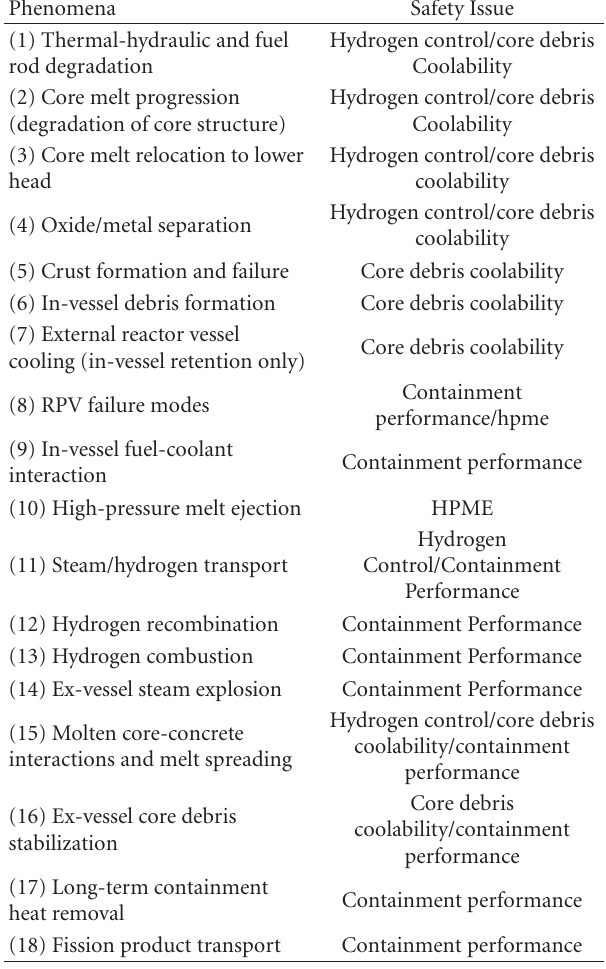
Table 1: Identification of severe accident processes and phenomena for generic